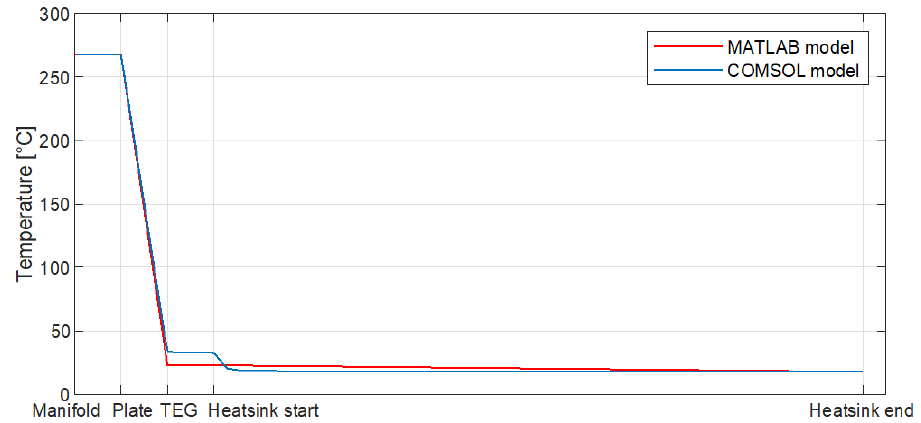
Figure 10. The 1D thermal resistance model vs. COMSOL model.